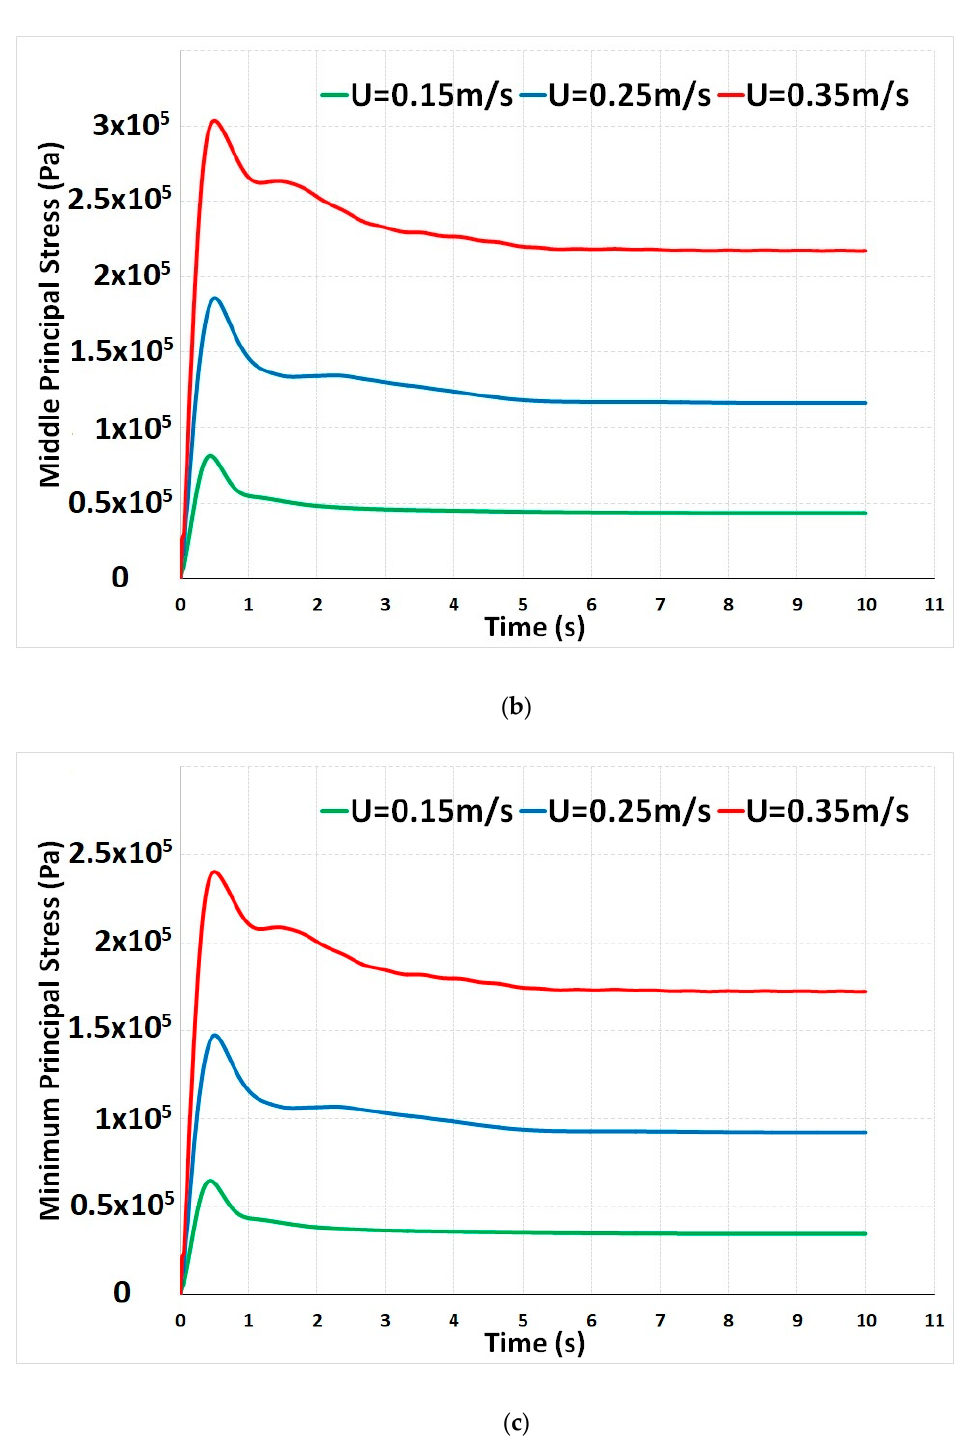
Figure 11. ( a ) Variation of maximum principal stress of T-shaped flexible beam between t = 0 s and 10 s. ( b ) Variation of middle principal stress of T-shaped flexible beam between t = 0 s and 10 s. ( c ) Variation of minimum principal stress of T-shaped flexible beam between t = 0 s and 10 s.